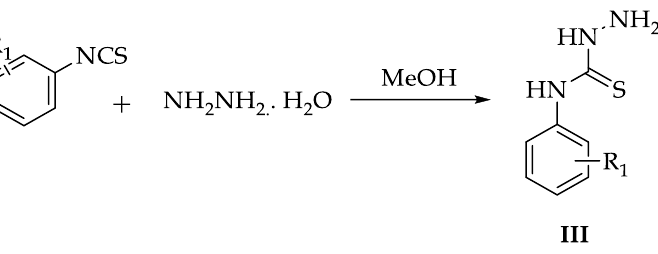
Scheme 2. Synthesis of thiosemicarbazide derivatives.